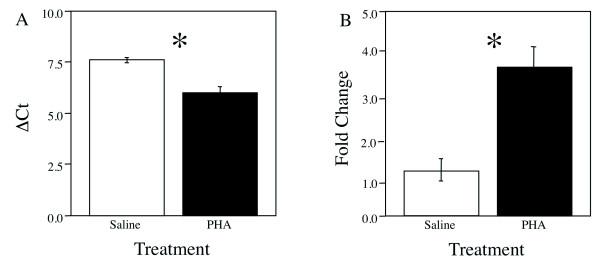
Bar graph showing the mean ± SEM in ΔCt values (normalized against GAPDH, (A)) and fold change (B) between saline and PHA treated telencephalons for aromatase. Fold change in expression was calculated using the double delta Ct method assuming 100% efficiency. * denotes a significant difference between treatment and saline.